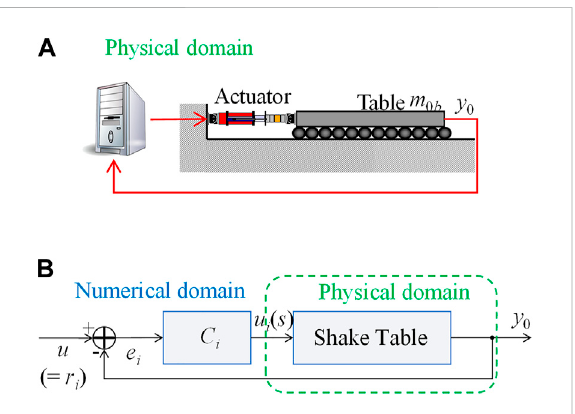
FIGURE 1 Shake table control with the bare condition: (A) conceptual drawing and (B) block